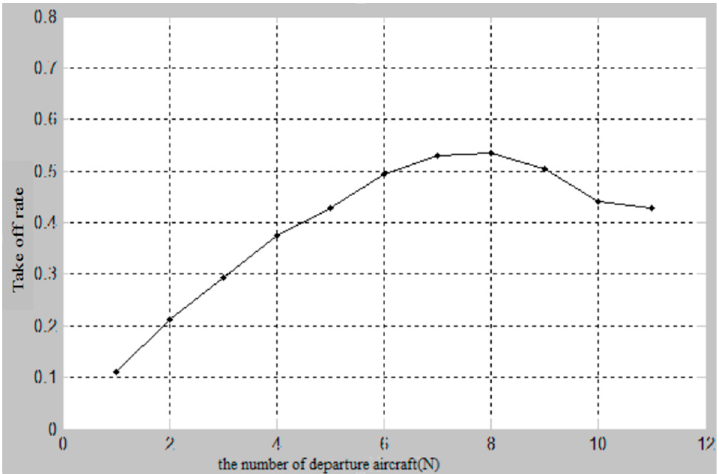
Figure 3. The relationship between the takeoff rate and the number of departure aircraft.